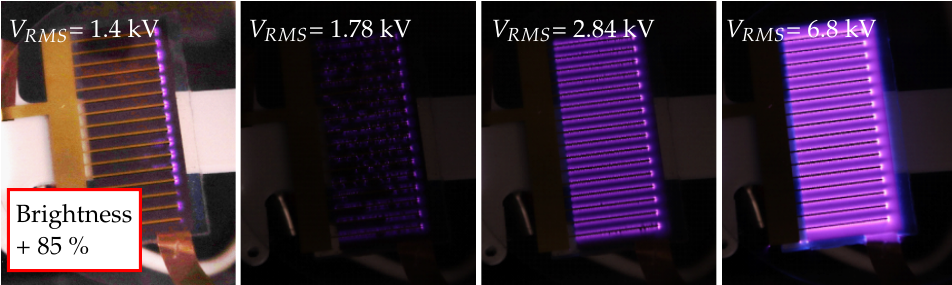
Figure 6. SLR-camera images of the plasma expansion of the glass SDBD at different operating